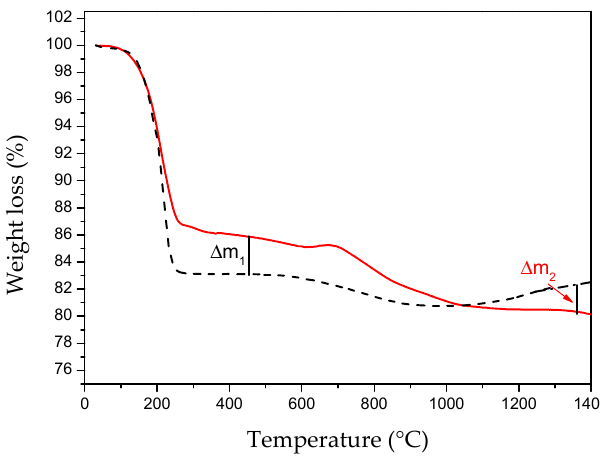
Figure 6. TGA curves recorded on two reference samples; pure polyborazilene (PBN) ( dashed line ) and PBN mixed with Li 3 N micro powders (5wt. %) (PBN-Li 3 N) ( red line ). Comparison of both curves shows three main differences. First, a lower weight loss for PBN-Li 3 N sample at 600 °C: 13% vs. 17% for PBN sample is observed, the difference ( Δ m 1 ) indicating the additive preservation. The second difference corresponds to a higher weight loss for the additivated sample between 600 and 1000 °C interpreted as the removal of the additive or a product derived from the latter stage. Based on previous articles, we can assume that at this temperature range, a reaction occurs between Li 3 N and the former BN to get Li 3 BN 2 [96,97]. This specie can exist through two different structures α -Li 3 BN 2 and β -Li 3 BN 2 melting at 860 °C and 920 °C, respectively, so likely to be eliminated under the N 2 flow. Finally, the last divergence comes from the behavior of both products up to 1200 °C. Actually, the TGA curve recorded on the BN derived from the PBN-Li 3 N sample stays stable up to 1400 °C, meaning that the sample is not changing. Besides, the TGA curve from the BN produced from the pure PBN gains mass ( Δ m 2 ) and this non-expected behavior can be attributed to oxidation (with residual air in the chamber) [53] meaning that the sample is not stable and sensitive to oxidation probably because of a worse crystallization [98].